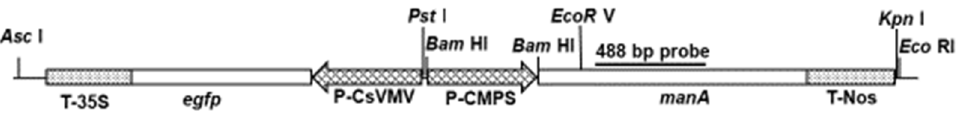
Figure 3. The expression cassettes of plasmid p2820eGFP showing P-CsVMV, the Cassava Vein Mosaic Virus (CsVMV) promoter, e gfp , enhanced green fluorescence protein gene, T-35S, the cauliflower mosaic virus 35S terminator, P-CMPS, the Cestrium yellow leaf curling virus promoter, manA , mannose-6-phosphate isomerase gene from E. coli , T-Nos, the nopaline synthase gene terminator. The size of the expression cassettes is 4.1 kb and the entire plasmid size is 6.4 kb. The probe for Southern blot is 488 bp in manA coding region.